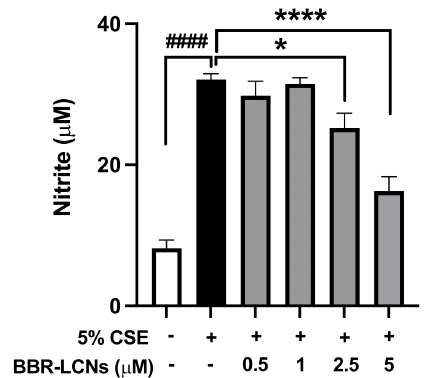
Figure 6. Effect of BBR-LCNs on NO production in RAW264.7 cells. NO production (in terms of nitrite) was quantified with Griess’ reagent by measuring absorbance at 540 nm. #### p < 0.0001 vs. control (without BBR-LCNs and 5% CSE treatment) and * p < 0.05; **** p < 0.0001 vs. 5% CSE. Values are expressed as mean ± SEM, n = 3 independent experiments. Analysis was performed with one-way ANOVA followed by Dunnett’s multiple comparison